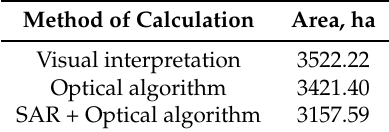
Table 3. The areas harvested within a year.